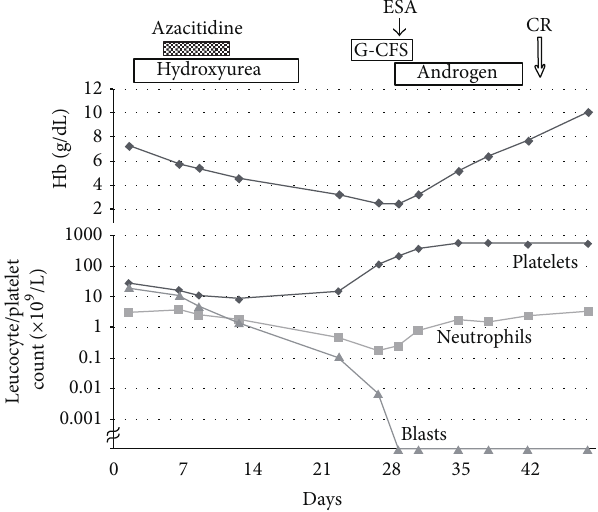
Figure 1: Clinical course of the patient during induction therapy with azacitidine. ESA: erythropoiesis-stimulating agent; G-CSF: granulocyte colony-stimulating